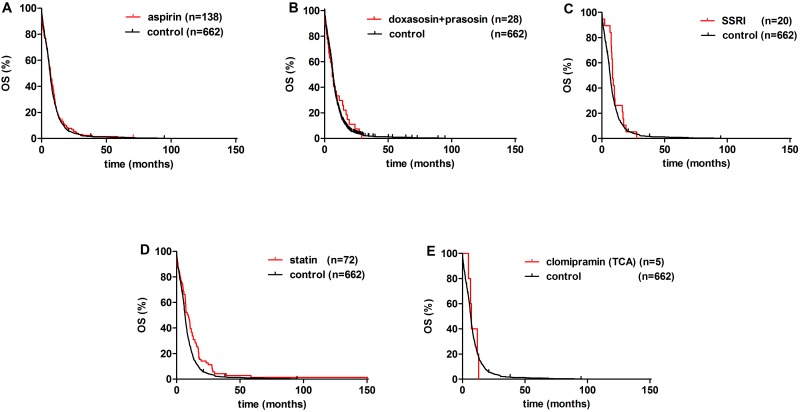
Kaplan-Meier curves for the OS of metastatic SCLC patients. Effect of FDA approved drugs.(A) Aspirin (vs. control; p = 0.225), (B) doxazosin and prazosin (vs. control; p<0.479), (C) selective serotonin reuptake inhibitors (SSRIs) (vs. control; p = 0.195), (D) statin treatment vs. control (p = 0.002) and, (E) clomipramine (a tricyclic antidepressant; TCA) vs. control had no effect on OS.